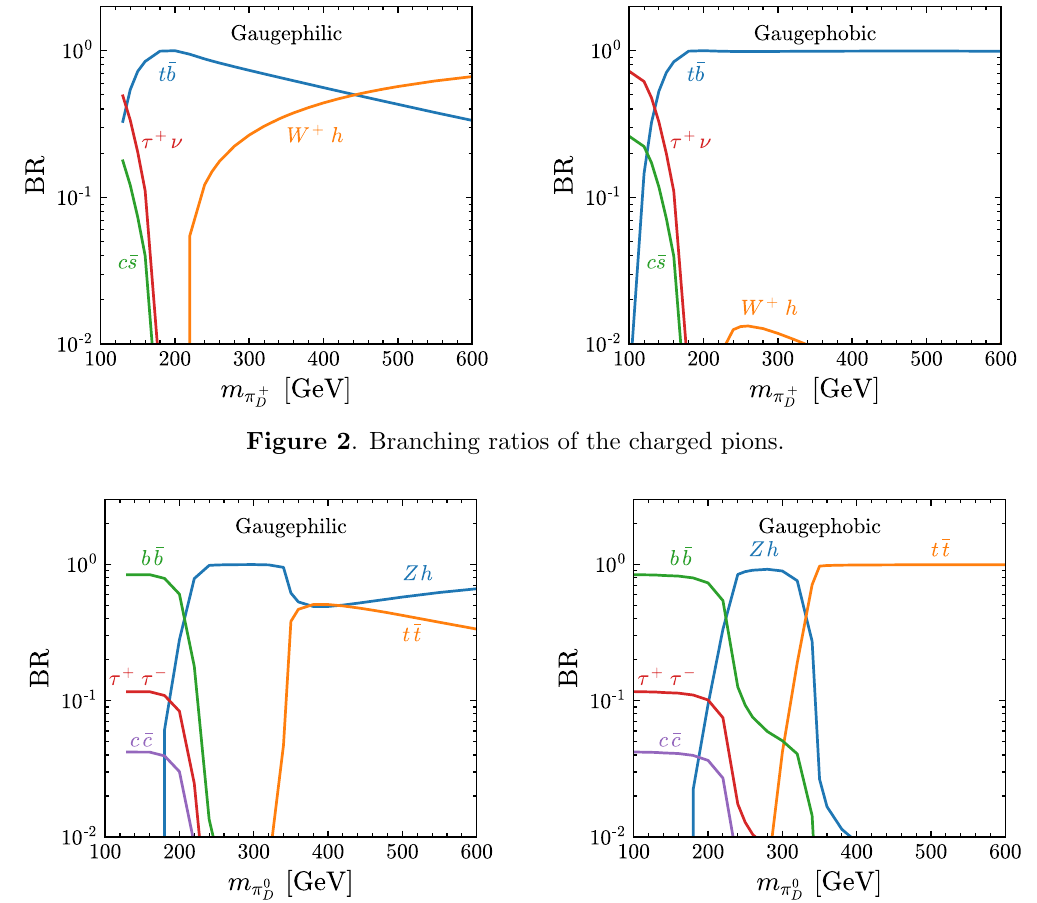
Figure 3 . Branching ratios of the neutral